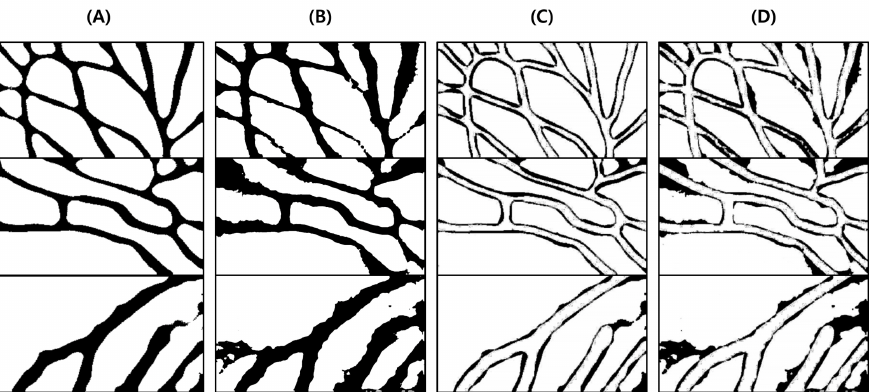
Figure 19. Results of applying SSIM to the results of the proposed and Veinvu-100 algorithms: ( A , B ) are binary images of the results of applying the proposed and Veinvu-100 algorithms, respec- tively, and ( C , D ) are results of comparing ( A , B ) with the vessel layer using